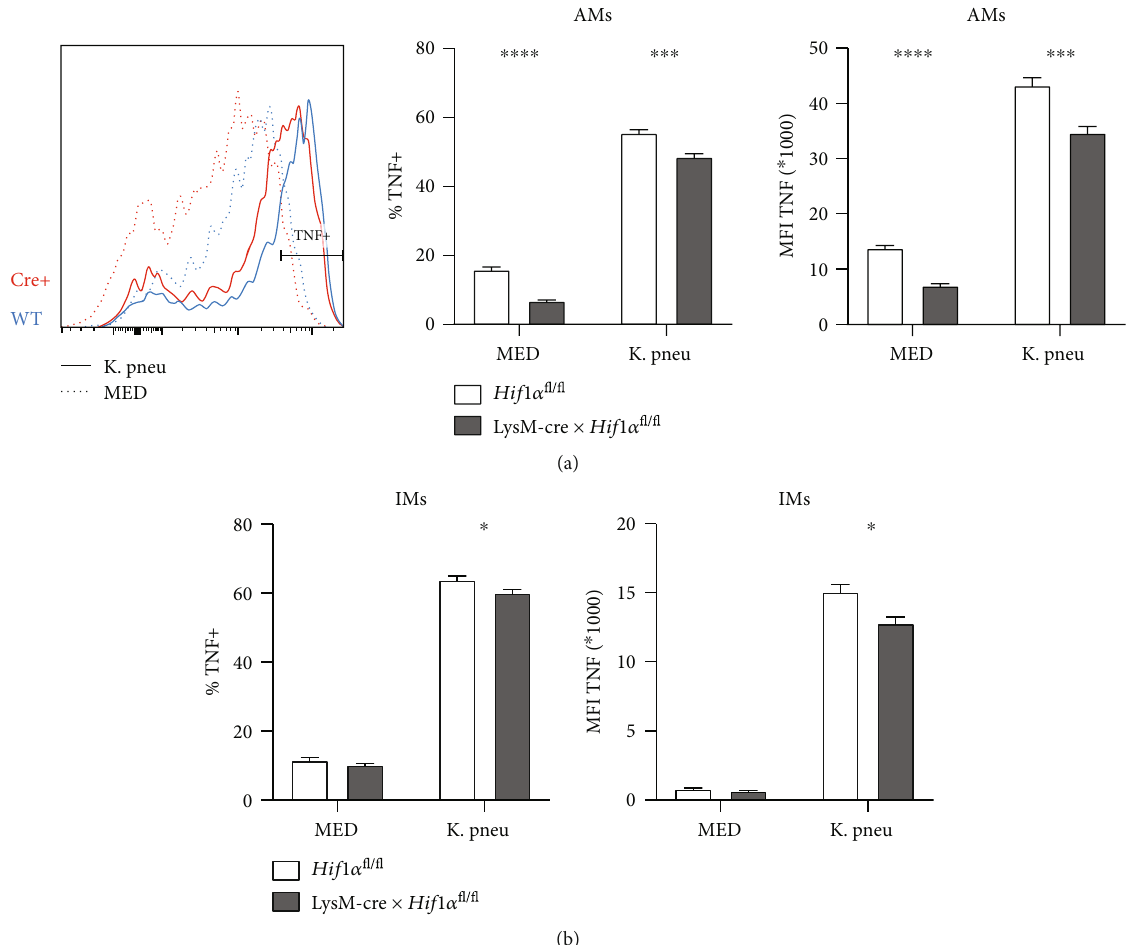
Figure 4: HIF1 α de fi ciency a ff ects TNF production capacity of AMs and IMs. Percentage TNF-positive cells and the mean fl uorescent intensity (MFI) of the TNF staining of AMs (a) and IMs (b) from LysM-cre × Hif1 α fl / fl (Cre+) and control mice (WT) after stimulation of lung suspensions for 2.5 hours with heat-killed K. pneumoniae (K. pneu) or medium control (MED). Data are shown as bar graphs showing mean with standard error of the mean from 10 mice per group. MFIs and percentage positive cells were compared using Student ’ s t -tests followed by the Holm-Sidak multiple comparison test. ∗ P < 0 : 05 ; ∗∗ P < 0 : 01 ; ∗∗∗ P < 0 : 001 ; ∗∗∗∗ P < 0 : 0001